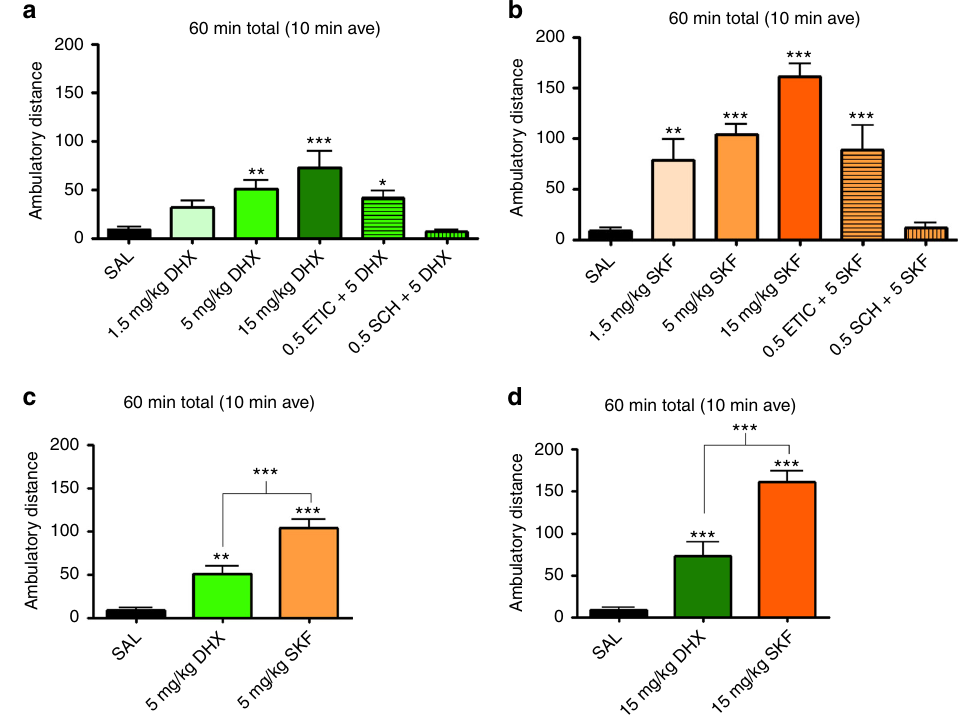
Fig. 5 a , b Effect of D1R agonists on locomotion induced in reserpine-treated mice for DHX ( a ) and SKF81297 ( b ). Six bar group represents saline injection, 1.5 mg/kg, 5 mg/kg, 15 mg/kg, 5 mg/kg + 0.5 mg/kg eticlopride, 5 mg/kg + 0.5 mg/kg SCH23390 (left to right). c , d Comparison of the ambulatory distance between DHX and SKF81298 at 5 mg/kg ( c ) and 15 mg/kg ( d ). Values were statistically analyzed by one-way analysis of variance (ANOVA) followed by Newman-Keuls post hoc test. p -values are as indicated: * p < 0.05, ** p < 0.01 or *** p < 0.001. The error bars represent